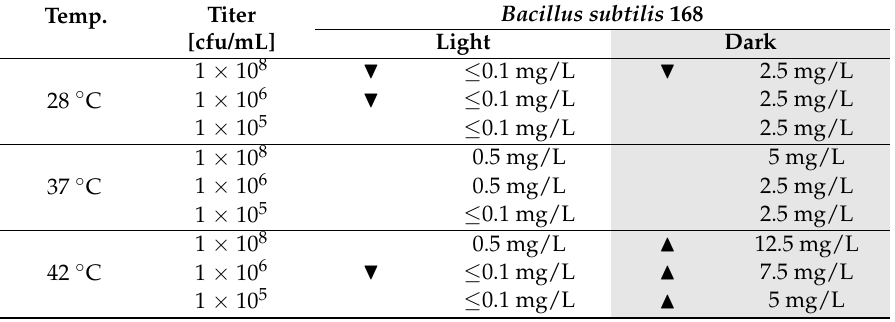
Table 5. Temperature-dependent MIC values of extracted chlorophyllin against Bacillus subtilis 168. MICs were determined in light (bright column) or darkness (grey column). Bacillus subtilis 168 Temp. Titer [cfu/mL]